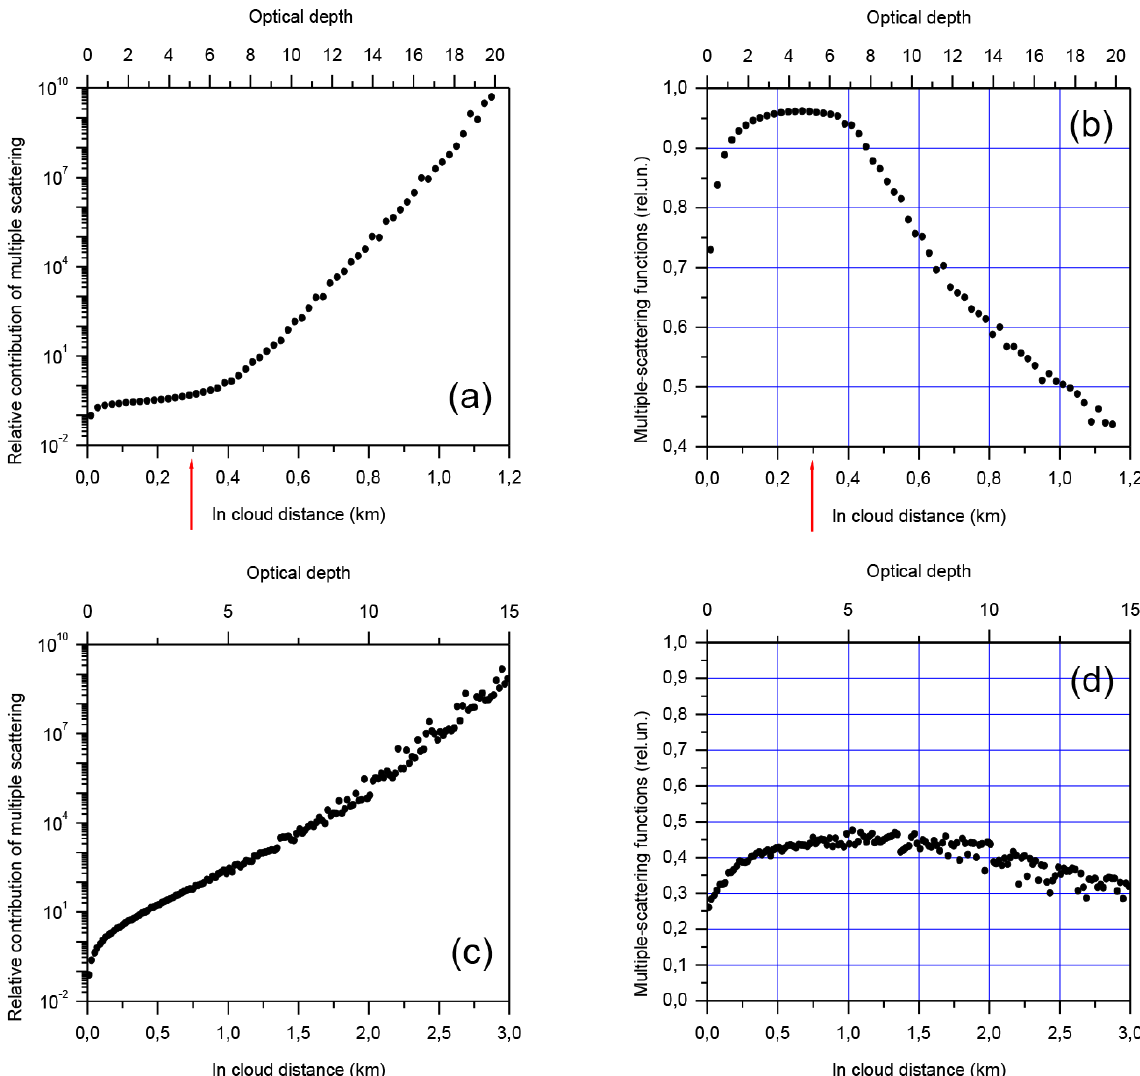
Figure 2. Multiple-scattering contributions R MSto1 to lidar signals (a, c) and multiple-scattering functions η MS (d) (b, d) . MUSCLE case (a, b) , CALIOP case (c, d) . The red arrow indicates the far end of the MUSCLE comparison (Bissonnette et al.,